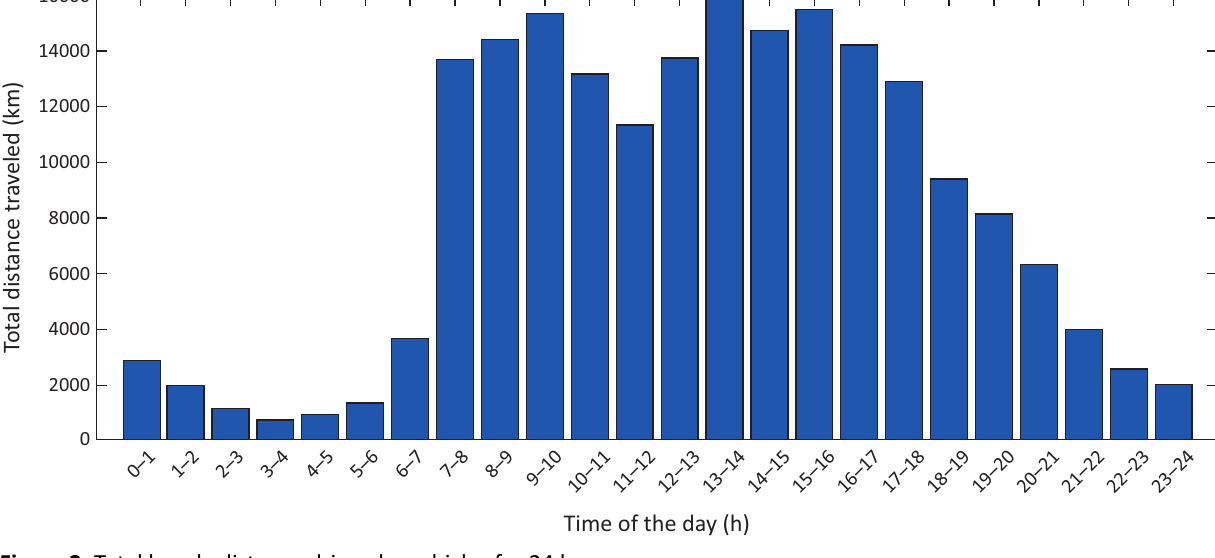
Figure 2. Total hourly distance driven by vehicles for 24 hours.